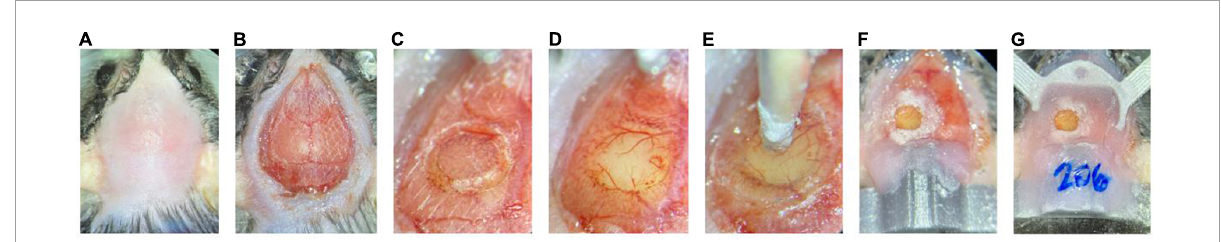
FIGURE3 Surgical steps. (A) Mouse fixed in stereotaxic frame with a cleared surgical site; (B) Droplet-shaped removal of the skin to expose the skull and Vetbond tissue adhesive applied to the edges of the scored skull; (C) Drilling of 3 mm cranial window; (D) Bone flap removed to expose the brain; (E) Glass plug placed, toothpick lowered, and glue applied to window edges. Potential bleeding below the silicone will reabsorb within a few days; (F) Meliodent applied in multiple components to secure the window, the collar head piece, and the frontal head piece; (G) Chronic cranial window, frontal head holder, and collar head holder fixed to the skull with